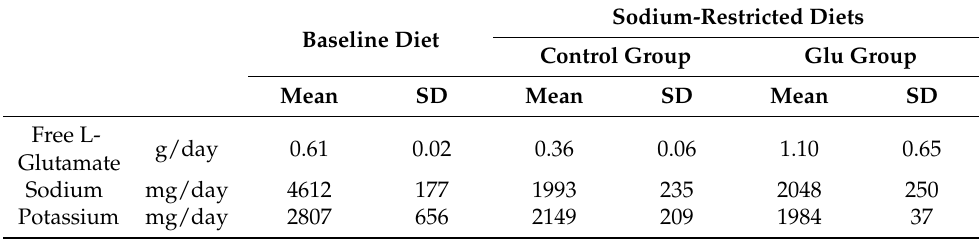
sodium-restricted diet with umami substance